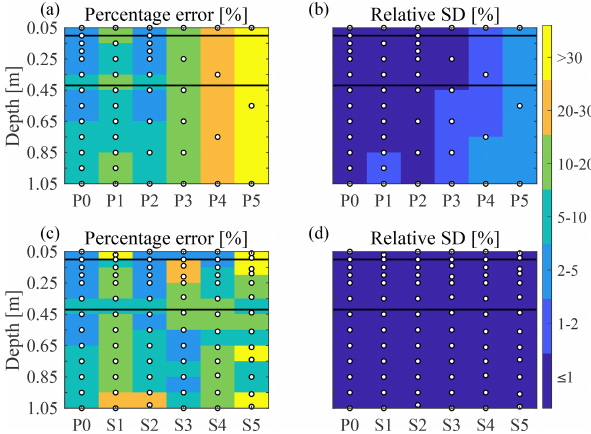
Figure 4. MCMC inversion results with a 7d sliding time win- dow to evaluate the impact of different temperature sensor geome- tries. (a) Percentage error (Eq. 7) and (b) relative standard deviation (Eq. 8) at each depth when using different numbers and positions of the temperature sensors (white dots). (c) Percentage error (Eq. 7) and (d) relative standard deviation (Eq. 8) at each depth when con- sidering different potential mispositioning of the temperature sen- sors (white dots). The black bold horizontal lines depict the position of soil interfaces in the “true” synthetic thermal diffusivity